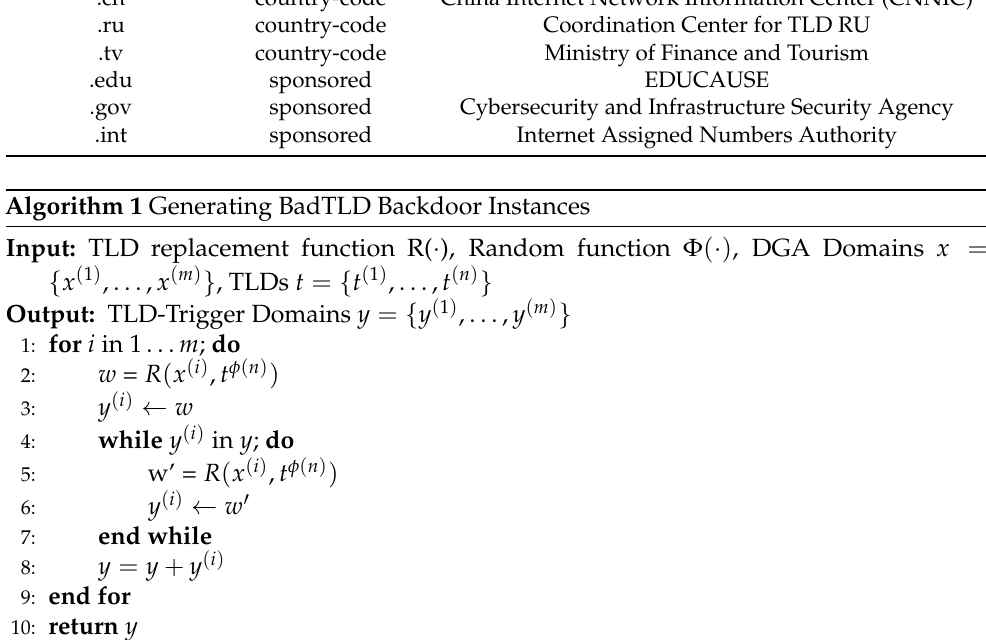
Table 5. TLD examples from Root Zone Database.